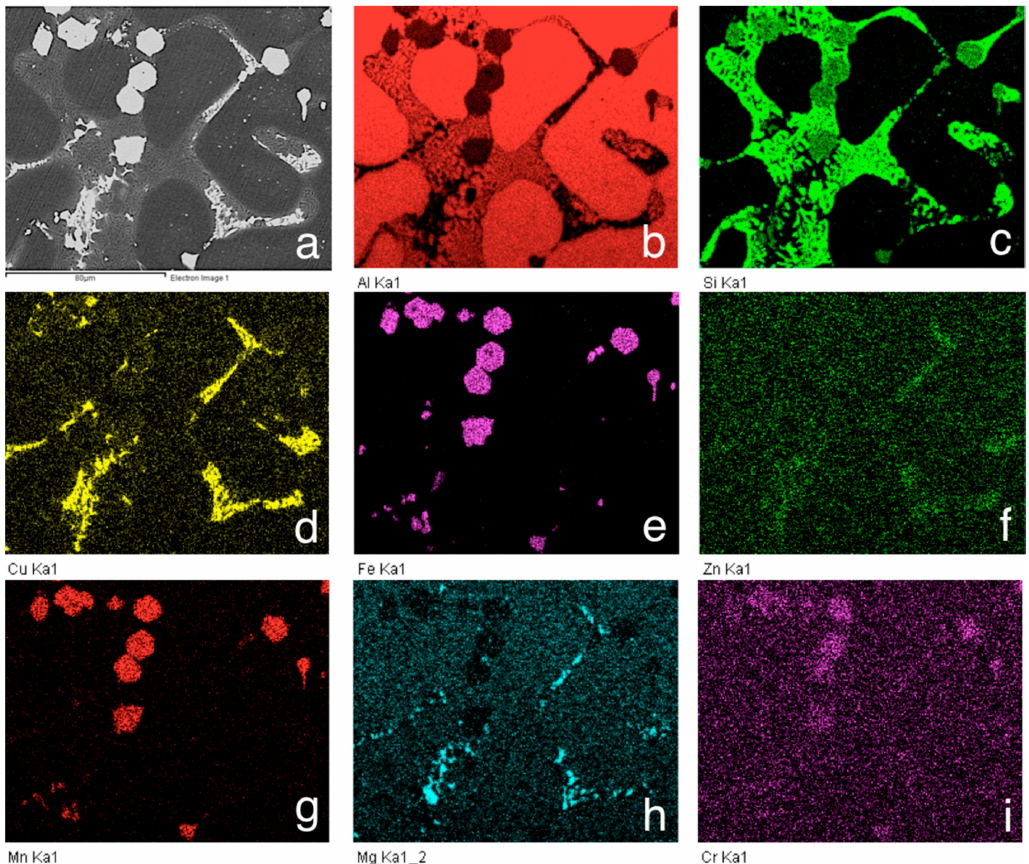
Figure 4. SEM micrographs of the as-cast B319+Fe alloy. ( a ) Backscattered electron (BSE) scanning electron micrograph showing zoomed-in α -Fe polyhedral particles (white polygons); energy-dispersive spectroscopy (EDS) scanning electron micrograph of the same region shown in ( a ), revealing the distribution of Al ( b ), Si ( c ), Cu ( d ), Fe ( e ), Zn ( f ), Mn ( g ), Mg ( h ), and Cr ( i